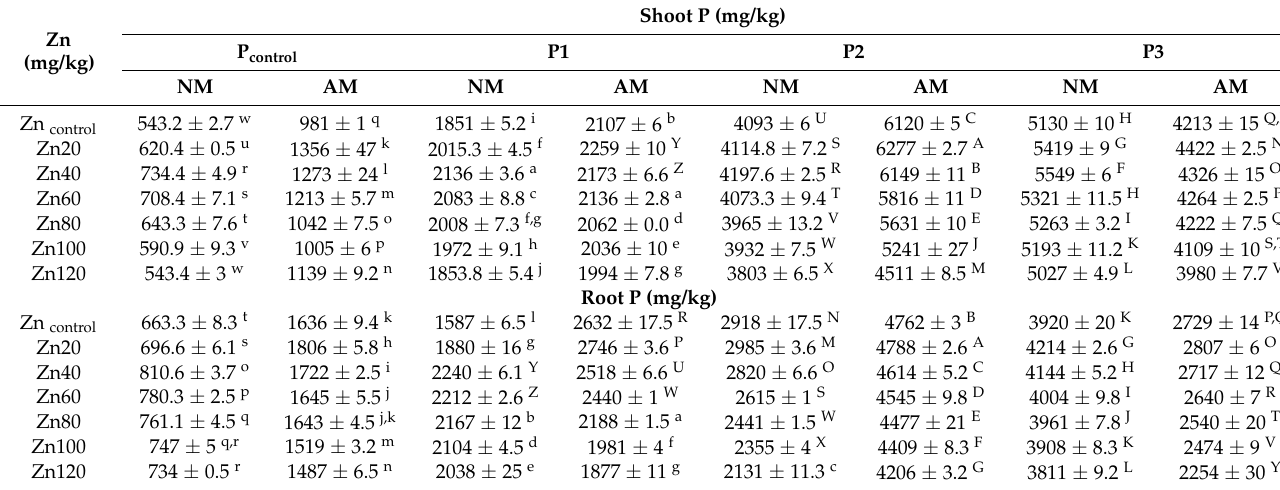
Mean values are presented ± standard error (SE). Different letters show significant difference at p ≤ 0.05. Capital letters indicate the highest values. After completely using upper case letters up to Z, lower case letters are used to show the decrease of mean values. AMF